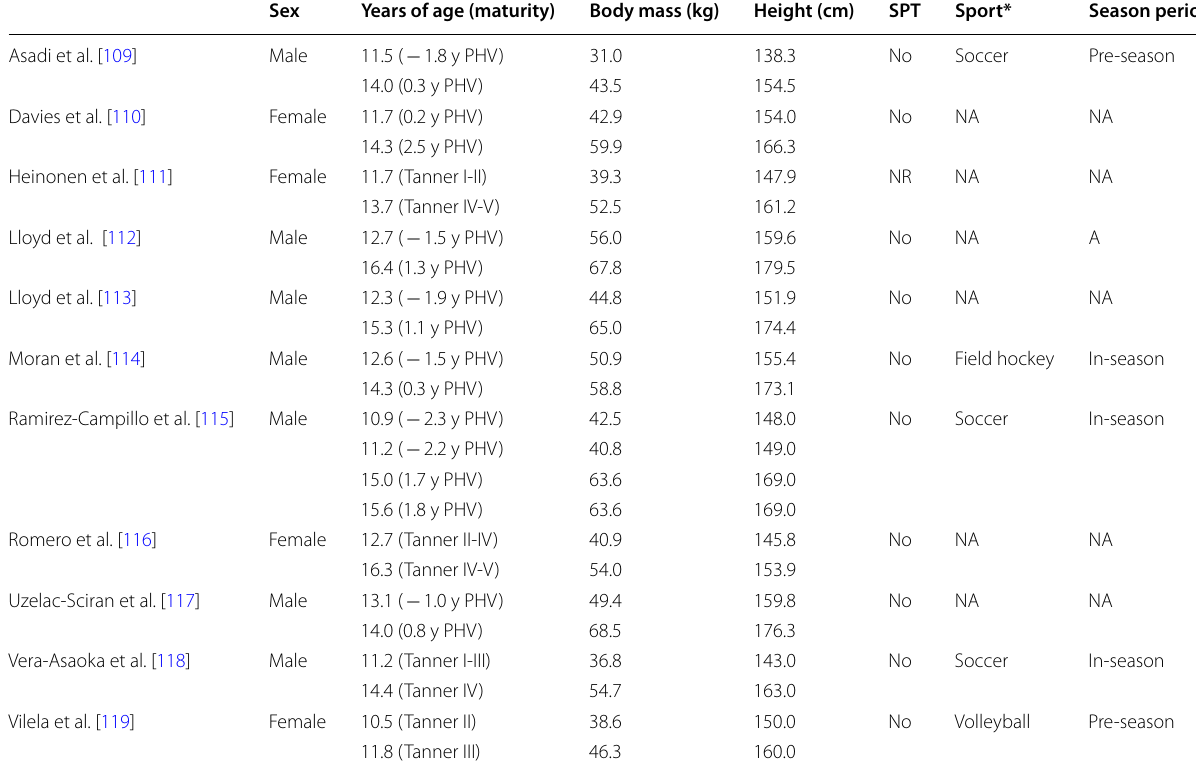
Table 3 Participants’